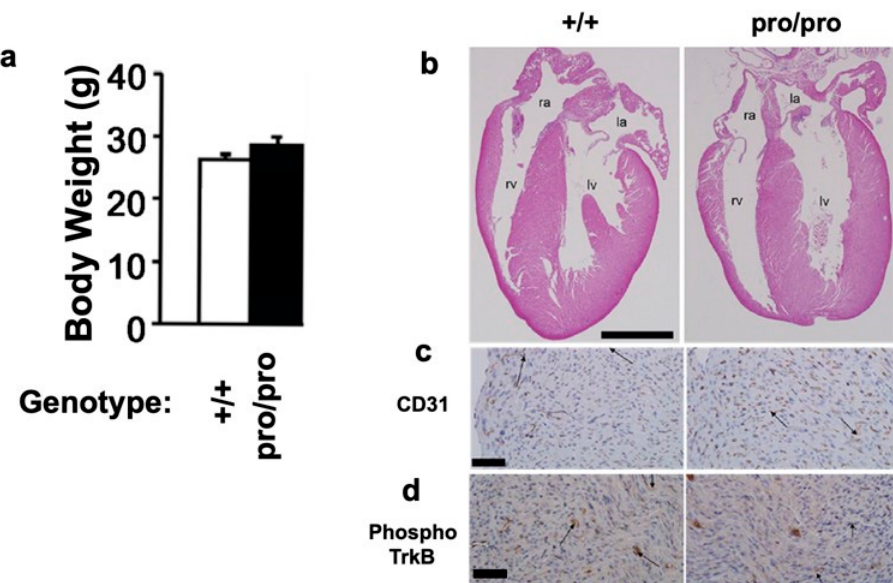
Figure 2. Body weights and heart morphology. ( a ) Mean body weights of 10-week-old BDNF +/+ and BDNF pro / pro animals. Error bars represent SEMs from 8 mice / group. ( b ) Hematoxylin and eosin-stained heart sections of 7-day-old mice with the indicated genotypes. The staining was performed as described by Donovan et al. [35]. Abbreviations: ra, right atrium; la, left atrium; rv, right ventricle; lv, left ventricle. ( c , d ) Immunostaining of BDNF +/+ and BDNF pro / pro heart sections using an antibody against CD31 ( c ) or phosphorylated TrkB. ( d ) Scale bars, 1 mm ( b ) and 50 mm ( c , d ).